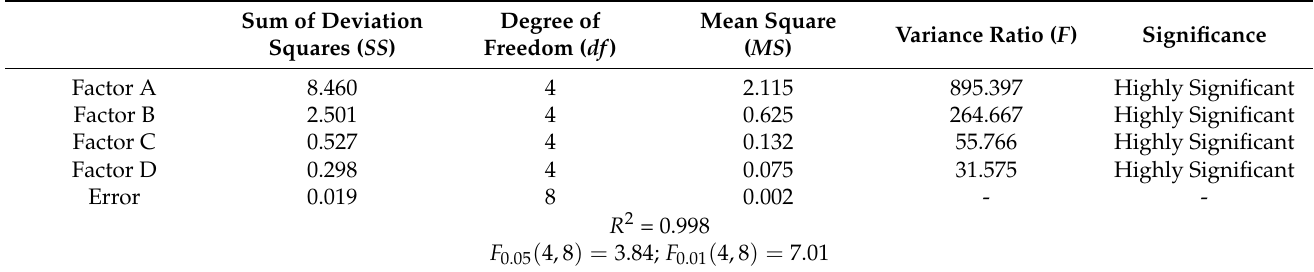
Table 5. ANOVA of indoor air